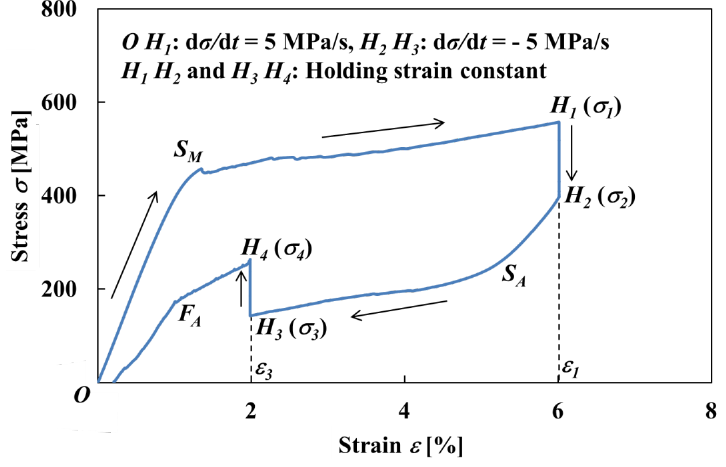
Figure 3. Stress-strain curve obtained by the test under a stress rate of dσ/d t = 5 MPa/s until a point H followed by holding strain constant at ε 1 until a point H followed by holding the strain constant at ε 3